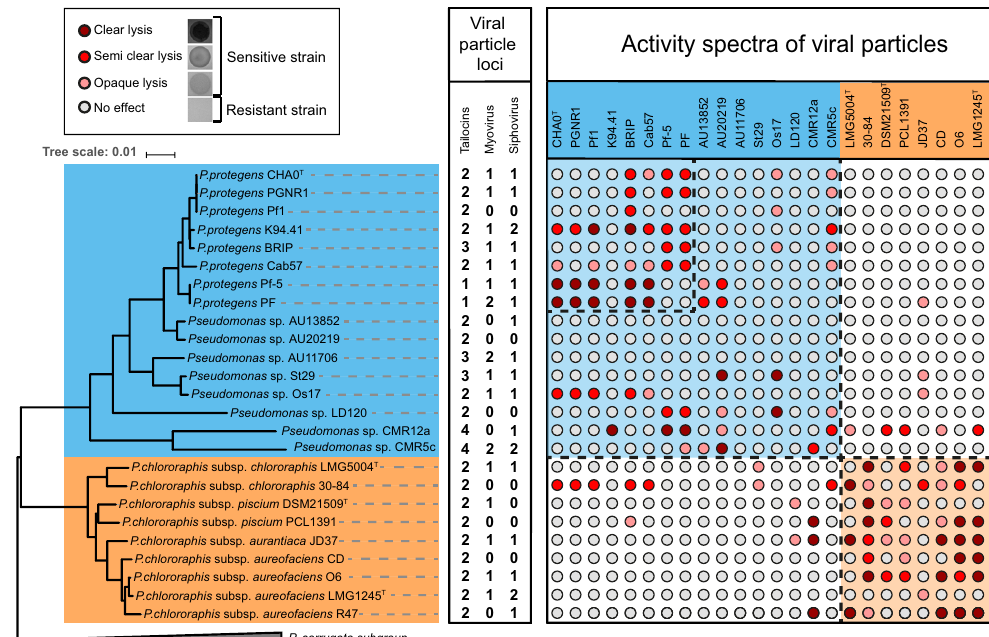
Fig. 1 Intraspeci fi c sensitivity of Pseudomonas protegens (Pp) and Pseudomonas chlororaphis (Pc) subgroup strains when confronted to their viral particles. The viral particle loci inventory was generated using PHASTER 35 and manually inspected to discriminate tailocin gene clusters from prophages by checking for genes encoding capsid-related proteins. The prophages were classi fi ed as either siphoviruses or myoviruses. No other phage family was detected. Soft agar cultures of the Pseudomonas strains (columns) were challenged with viral particles extracted from cultures of these same strains (rows). Strains producing clear, semi-clear or opaque lysis zones were scored sensitive to the viral particles, while strains producing no lysis zone were considered resistant. The boxes with the dashed lines in the table delimits the sensu-stricto P. protegens species, the Pp subgroup (blue) and the Pc subgroup some prophages can be maintained as defective prophages 20 .